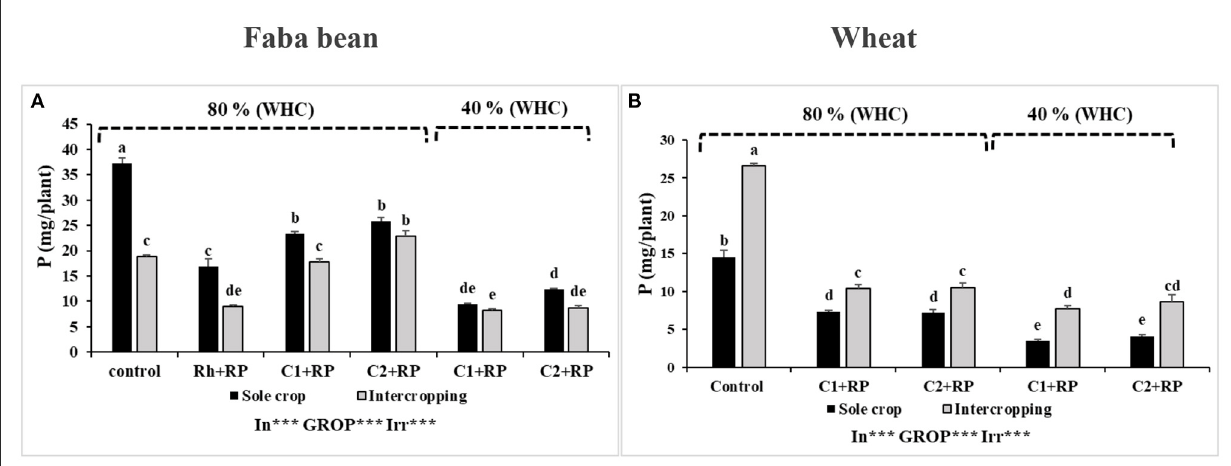
FIGURE9 Faba bean (A) and wheat (B) P contents. Plants were grown as a sole crop or intercropped under water sufficiency and P limitation (80% WHC, RP) vs. combined water deficit and P limitation (40% WHC, RP) and inoculated with two rhizobacterial consortia (C1 and C2) containing rhizobia and two PGPRs. The positive controls were supplemented with 125 µ mol/l of KH 2 PO 4 and 46 mg/l of KNO 3 (control). The negative controls received RP and were inoculated with the rhizobia only (Rh + RP). Each value represents the mean ± standard error (SE) of three replicates (In, inoculation; GROP, type of cropping; Irr, irrigation). Values with different letters are significantly different at 0.05 level of probability by Student-Newman-Keuls. * Represent the significance level of treatments.